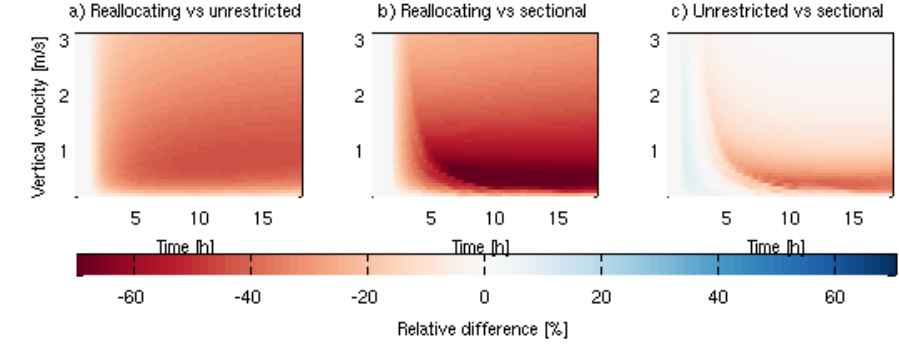
Figure 6: Relative difference of the cloud droplet number concentration between the three models in experiment 2.